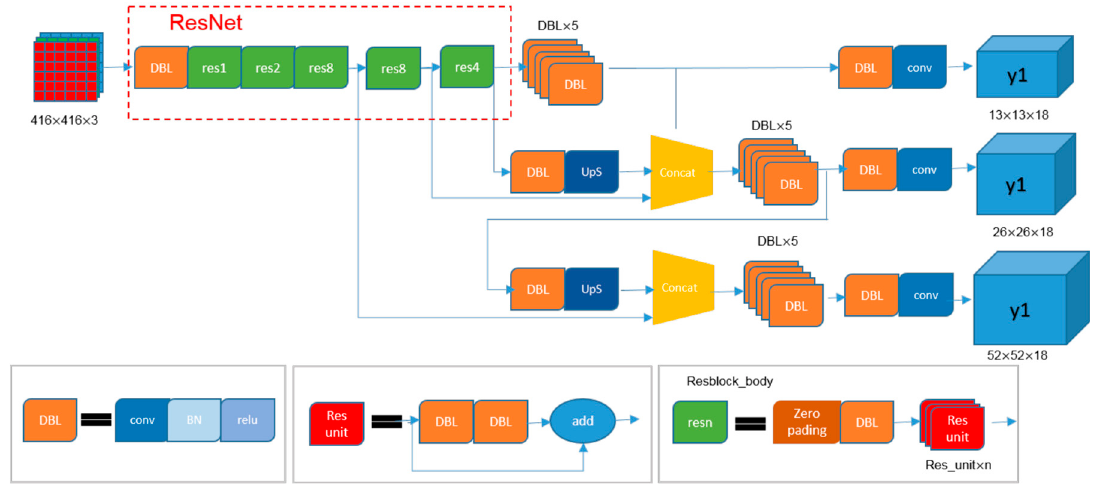
Figure 9. YOLOv3